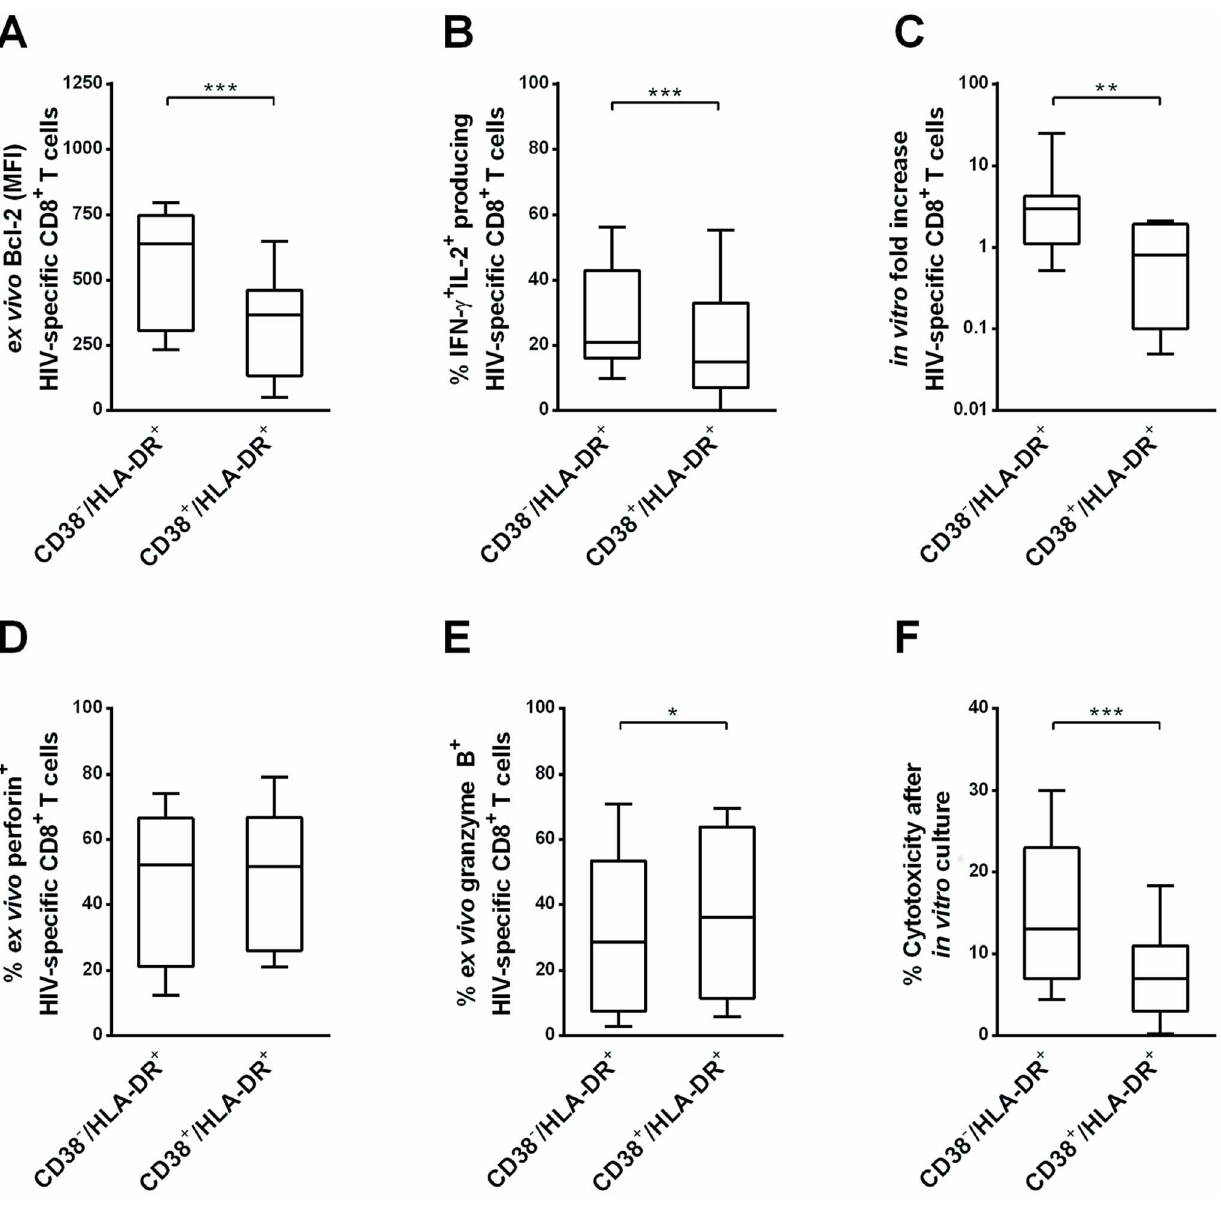
Figure 3. Qualitative features of CD38 2 /HLA-DR + and CD38 + /HLA-DR + HIV-specific CD8 + T cell subsets in HIC. (A) Bcl-2 expression on CD38 2 /HLA-DR + and CD38 + /HLA-DR + HIV-specific CD8 + T cells (n=11). (B) Proportion of CD38 2 /HLA-DR + and CD38 + /HLA-DR + HIV-specific CD8 + T cells producing both IFN- c and IL-2 among HIV-specific CD8 + T cells producing IFN- c or IL-2 (n=35). (C) Fold increase in CD38 2 /HLA-DR + and CD38 + / HLA-DR + HIV-specific CD8 + T cell numbers after 5 days of culture with HIV peptides (2 m M) (n=7). (D–E) Proportion of CD38 2 /HLA-DR + and CD38 + / HLA-DR + HIV-specific CD8 + T cells producing perforin (D) and granzyme B (E) (n=35). (F) Graphs representing percentage cytotoxicity (measured as granzyme-B-mediated intracellular cleavage of a fluorogenic substrate) of CD38 2 /HLA-DR + and CD38 + /HLA-DR + HIV-specific CD8 + T cells (n=11). * P , 0.05, ** P , 0.01, *** P , 0.001.